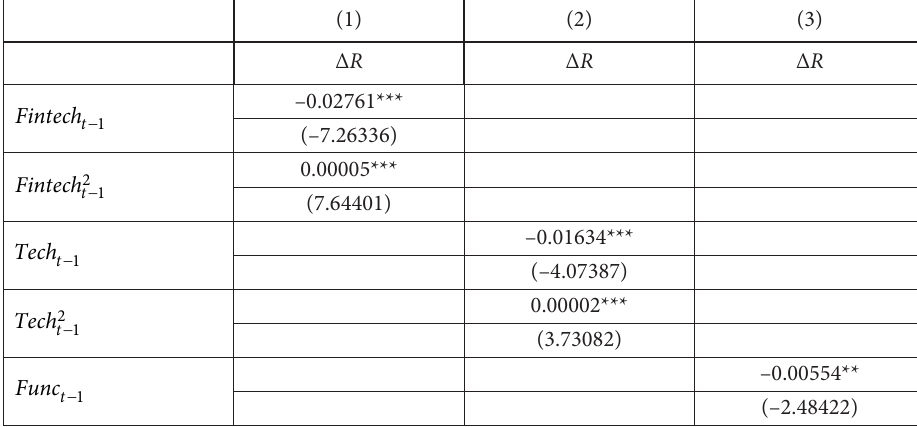
Table 6. Robustness